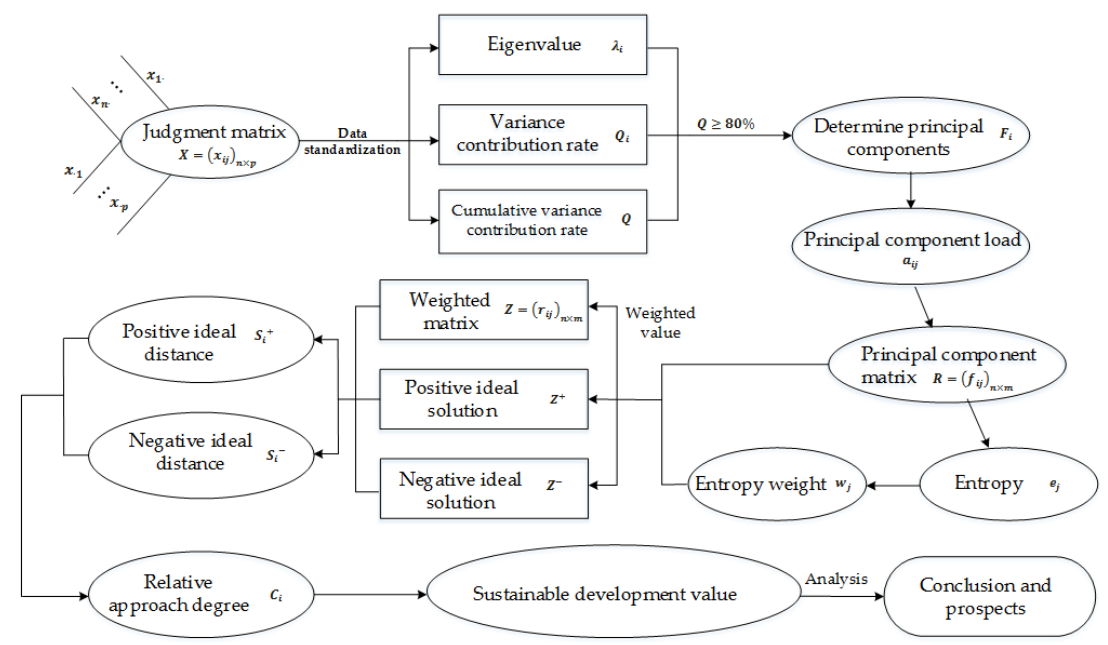
Figure 1. Measurement Model.